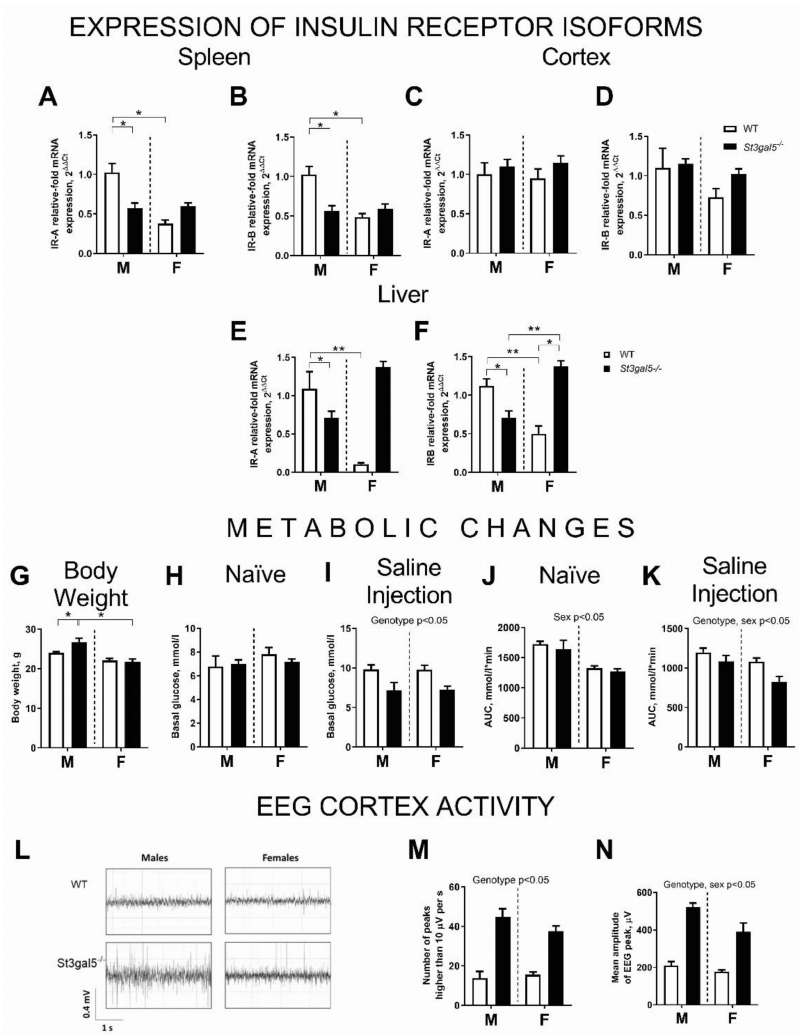
Figure 2. Metabolic changes, altered expression of insulin receptor isoforms, and EEG-parameters in St3gal5 − / − mice. There were significant group changes and a decrease in relative mRNA levels in male St3gal5 − / − mice in spleen ( A , B ) and liver ( E , F ) expression of ( A , E ) IRA and ( B , F ) IRB isoforms, but